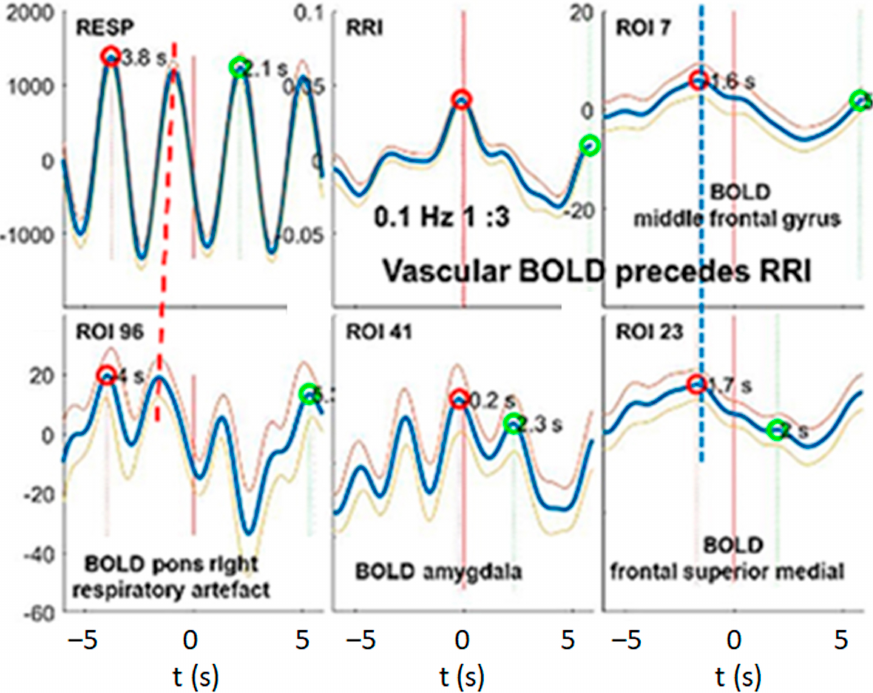
Figure 6. Example from subject #6 with dominant fast respiration in the 0.2–0.4 Hz band (for more detailed explanation, please see Figure 3). The RRI peak-triggered vascular BOLD waves were derived from MFG as depicted in the upper middle and right panels. The blue stippled vertical line indicates the maxima of slow BOLD waves about ~2 s before the RRI peak (longest RR interval), this means, a negative time delay indicating the vascular origin of the BOLD waves. Note the ~0.32 Hz oscillations in the amygdala (lower middle panel).